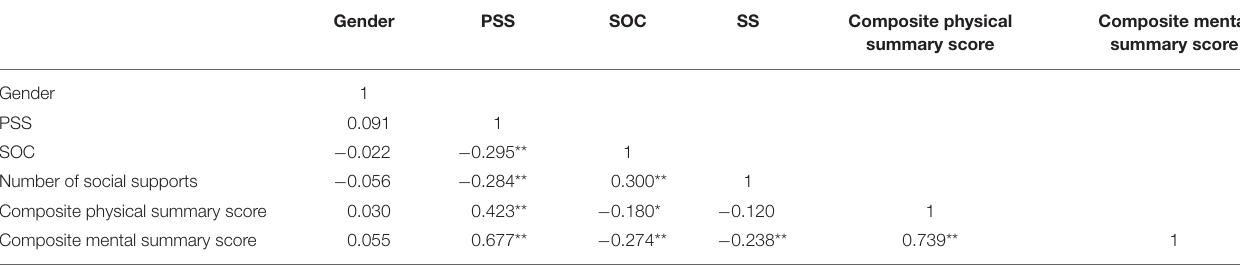
TABLE 1 | Correlations between the independent and dependent variables (seniors). Gender PSS SOC SS Composite physical